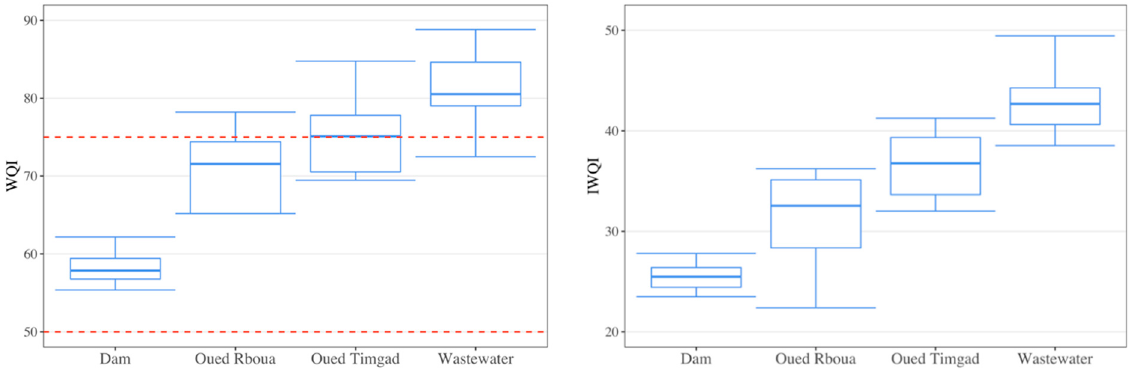
Figure 3. Boxplot of water quality index: WQI for drinking purposes ( left ) and IWQI for irrigation purposes ( right ).